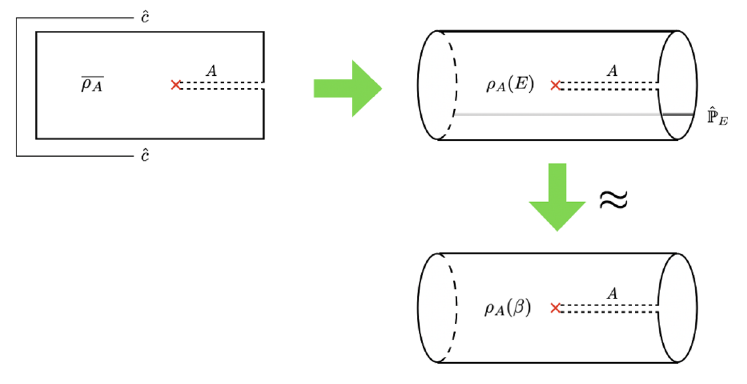
Figure 3 . Top: micro-canonical ensemble (cid:26) A ( E ) from averaging (cid:26) A (^ c ) over ^ c . Bottom: the equivalent canonical ensemble (cid:26) A ( (cid:12)